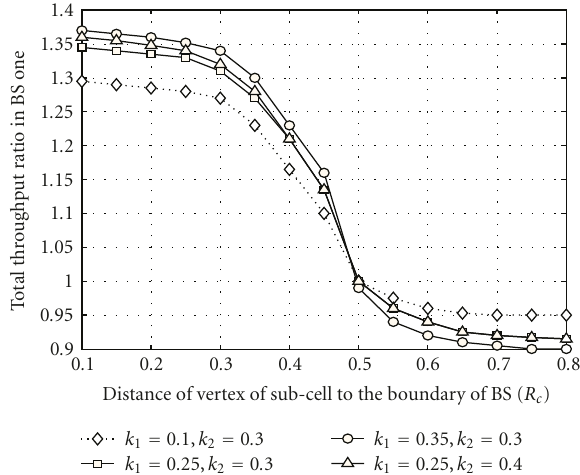
Figure 4: The ratio of the achieved throughput with relaying to the case without relaying in BS 1 versus the distance of the subcell to the BS for di ff erent values of k 1